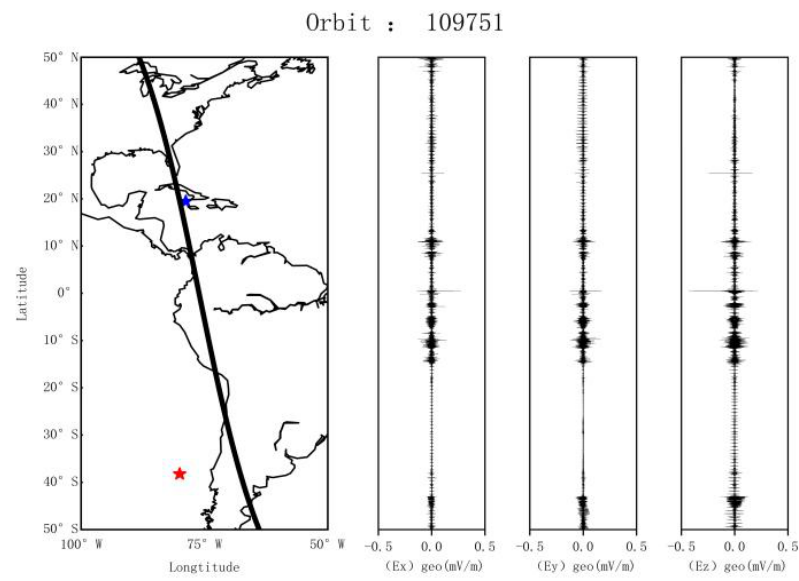
Figure 3. The residual waveform of the 109,751 orbit before the earthquake (the blue and red marks in the figure represent the epicenter and its magnetic conjugate point, respectively).